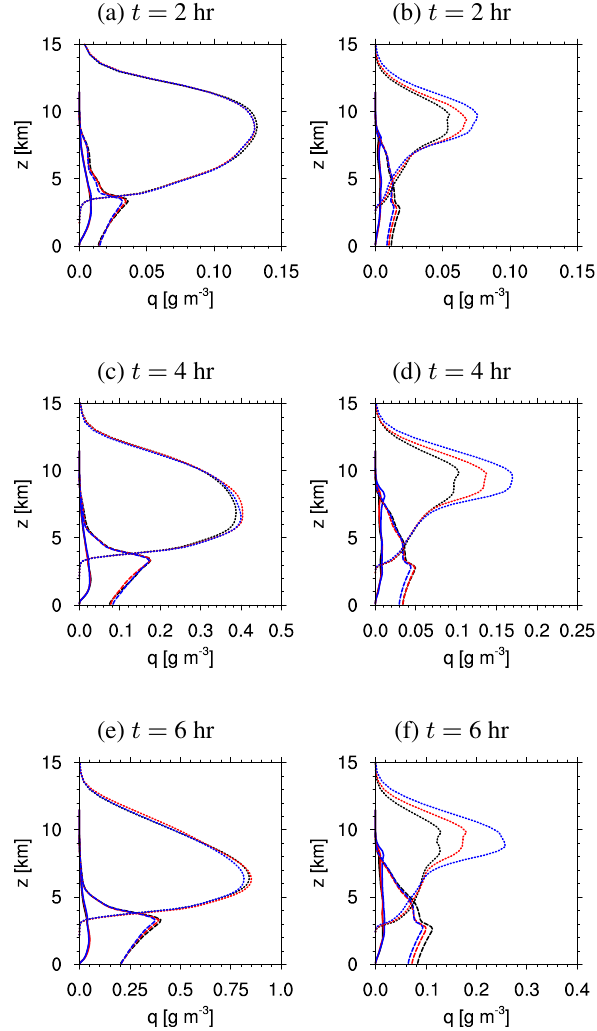
Fig. 6. Hourly domain-averaged cloud (solid), rain (dashed), and ice (dotted) water contents for the bulk (left) and bin (right) simulations. The aerosol sensitivity is shown for the “Clean” (black), “Semi-Polluted” (red), and “Polluted” (blue) scenarios. Note that the x -axes are different in order to clearly demonstrate changes in the bulk cloud properties with time and increased aerosol loading. Simulation time is shown in the subcaptions.